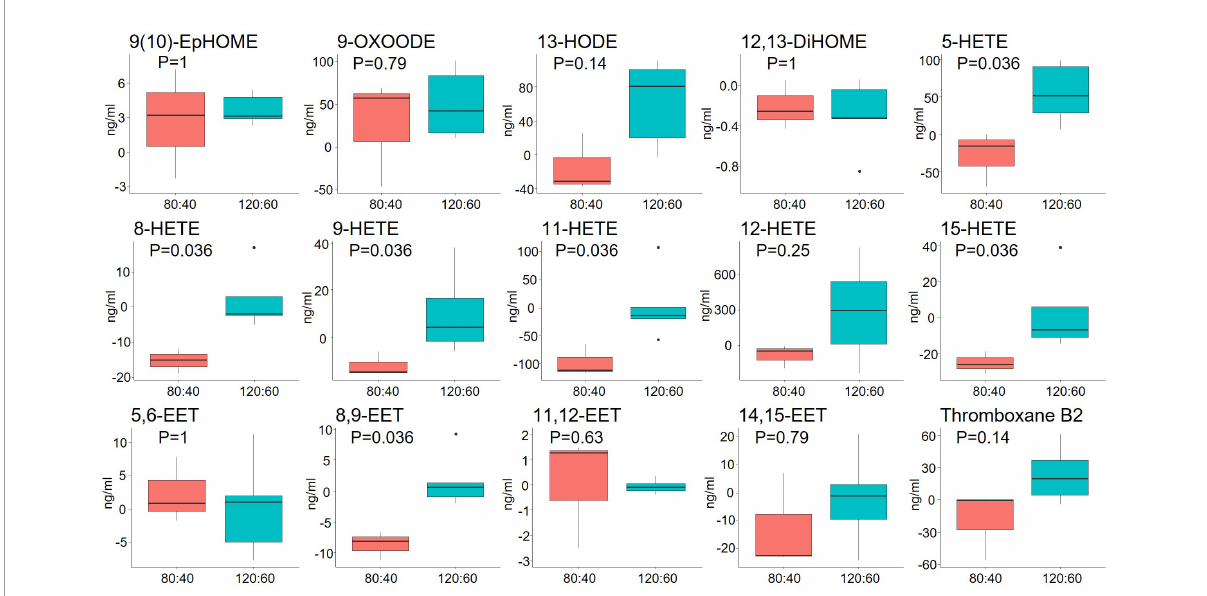
FIGURE2 Changes in whole blood oxylipins derived from omega-6 LCPUFAs from birth to 36 weeks’ postmenstrual age according to ARA:DHA group supplementation. Data show median and interquartile range [Q1; Q3]. The p -value was extracted from Mann–Whitney